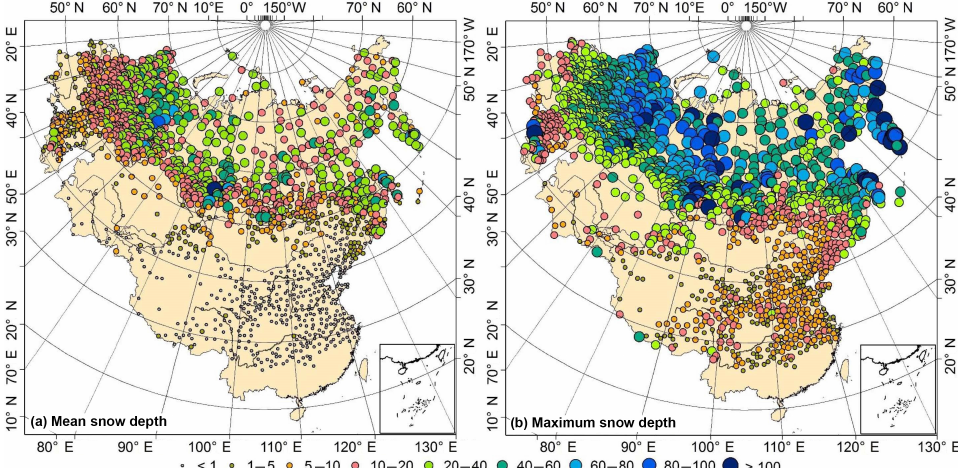
Figure 2. Long-term mean annual snow depth (a) and long-term mean maximum snow depth (b) across the Eurasian continent (cm) during the 1971–2000